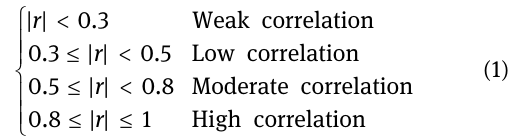
Figure 2 is the thermodynamic diagram of Pearson correlation coe ffi cient between parameters. The darker the color is, the higher the positive correlation is, and the lighter the color is, the higher the negative correlation is.